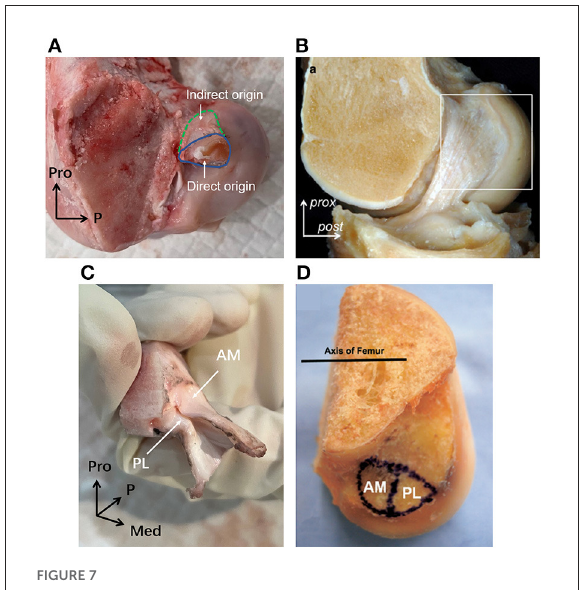
FIGURE7 The femoral origin of porcine and human ACLs. (A) The direct and indirect origin regions of porcine femoral ACL insertion. (B) The mid-substance and fan-like extension of human ACL femoral origin. (C) The AM and PL bundle femoral origin of porcine ACL. (D) The AM and PL bundle femoral origin of human ACL.